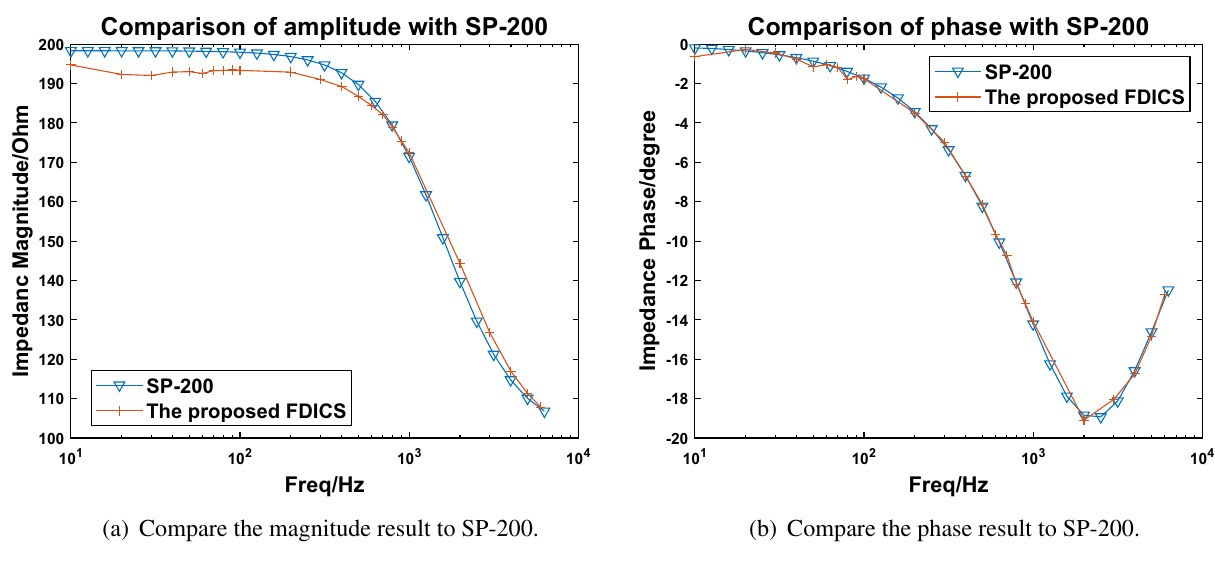
Figure 5. The comparison between the results from the FDICS and the SP-200 when testing on the circuit